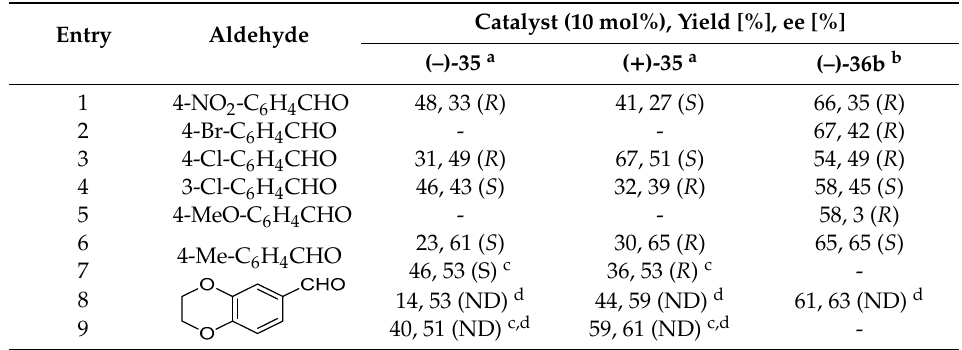
Table 6. Asymmetric allylation of benzaldehydes with allyltrichlorosilane catalyzed by 35 and (–)- 36b [53] .